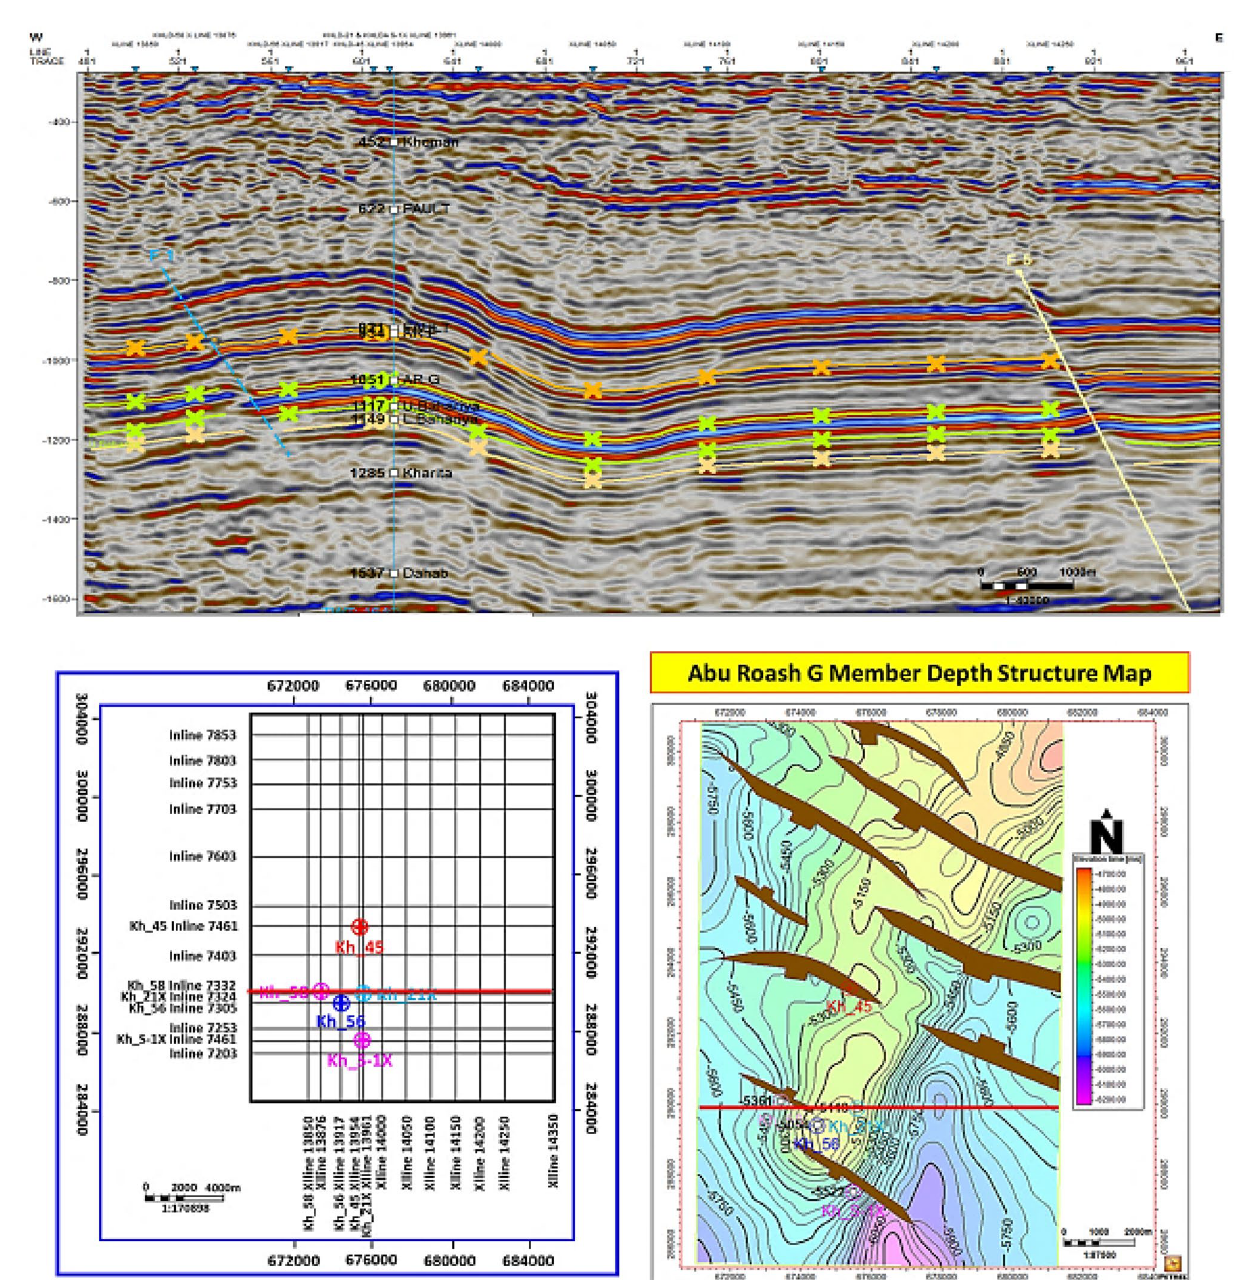
Fig. 10 The interpreted TWT seismic section that E–W and pass through the Kh_58 well. It shows a normal faulting with a somewhat folded structure along its downthrown side. The fault trends NW–SE direction with its dip direction toward